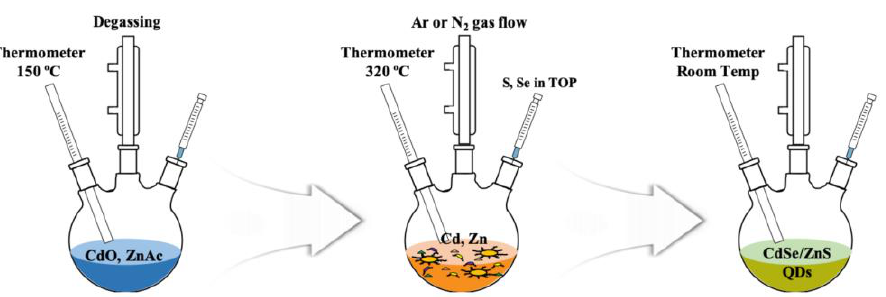
Figure 1. Schematic diagram of the synthesis of green light-emitting CdSe/ZnS quantum dots.